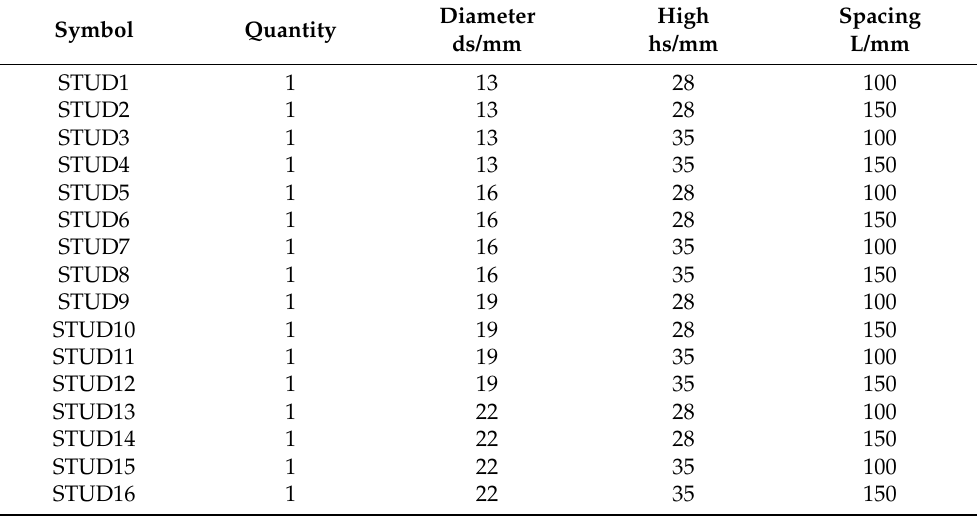
Figure 1. Dimensions and structure of the specimen (unit: mm): ( a ) Elevation; ( b ) Side view. Table 1. The grouping of the test specimens.